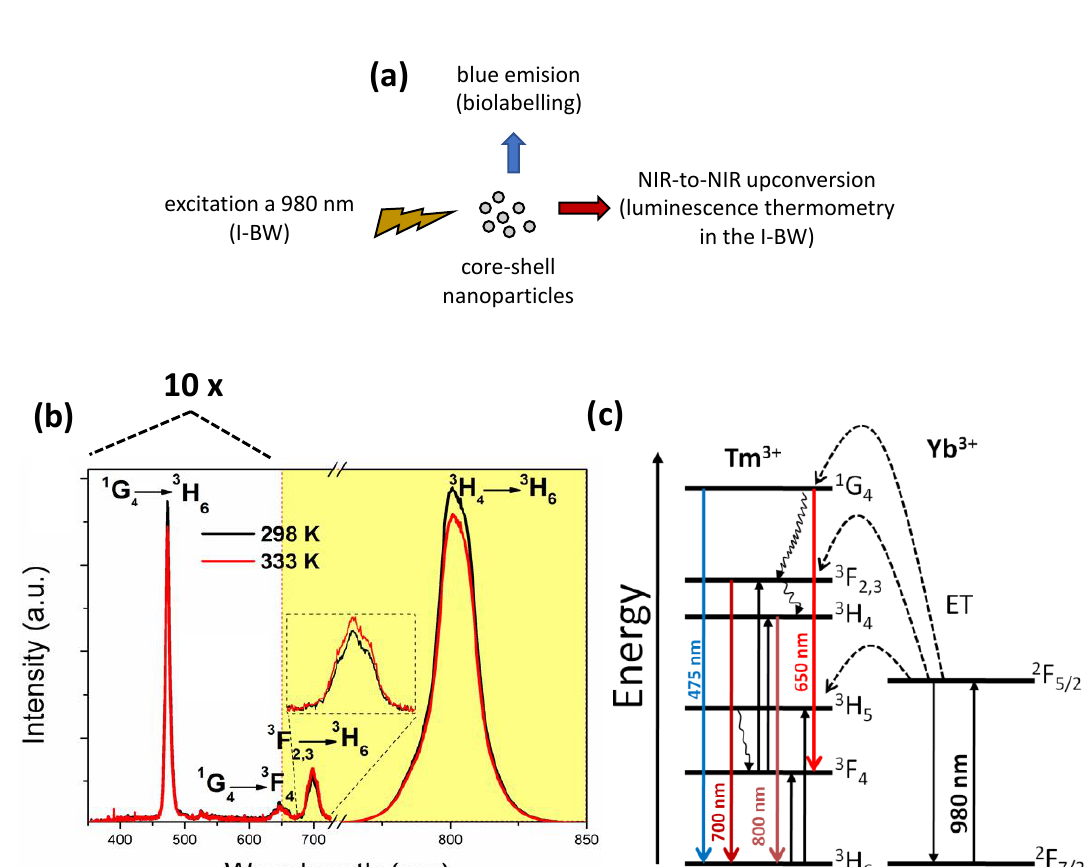
Figure 2. ( a ) Schematic representation of the pumping and emission bands generated by the Tm,Yb:GdVO 4 @SiO 2 core-shell nanoparticles, to illustrate their practical use as biolabels, with emission in the blue, and luminescent thermometers operating in the first biological window (I-BW). ( b ) Upconversion emission spectra of the Tm,Yb:GdVO 4 @SiO 2 core-shell nanoparticles at room temperature and at 333 K. Note that the visible part of the spectra, from 375 to 675 nm, has been magnified 10 times to respect the NIR part. The inset shows the magnification of the peak located at 700 nm, to make more evident the variation of the intensity of this peak with temperature. ( c ) Energy level diagram of Tm 3 + and Yb 3 + ions in GdVO 4 , indicating the absorption, energy transfer and emission pathways.